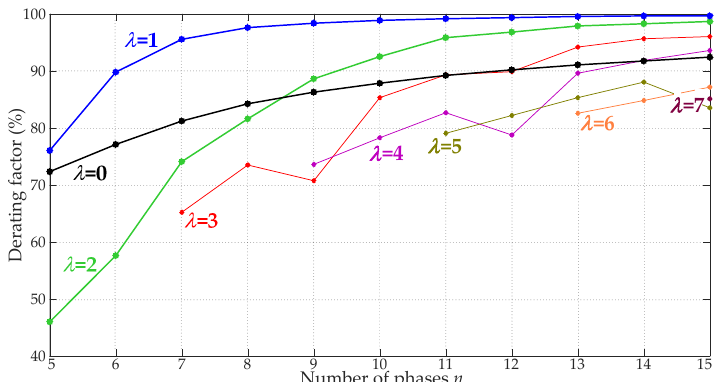
Figure 5. DF depending on n and the stator phase connection λ , for single-line OC